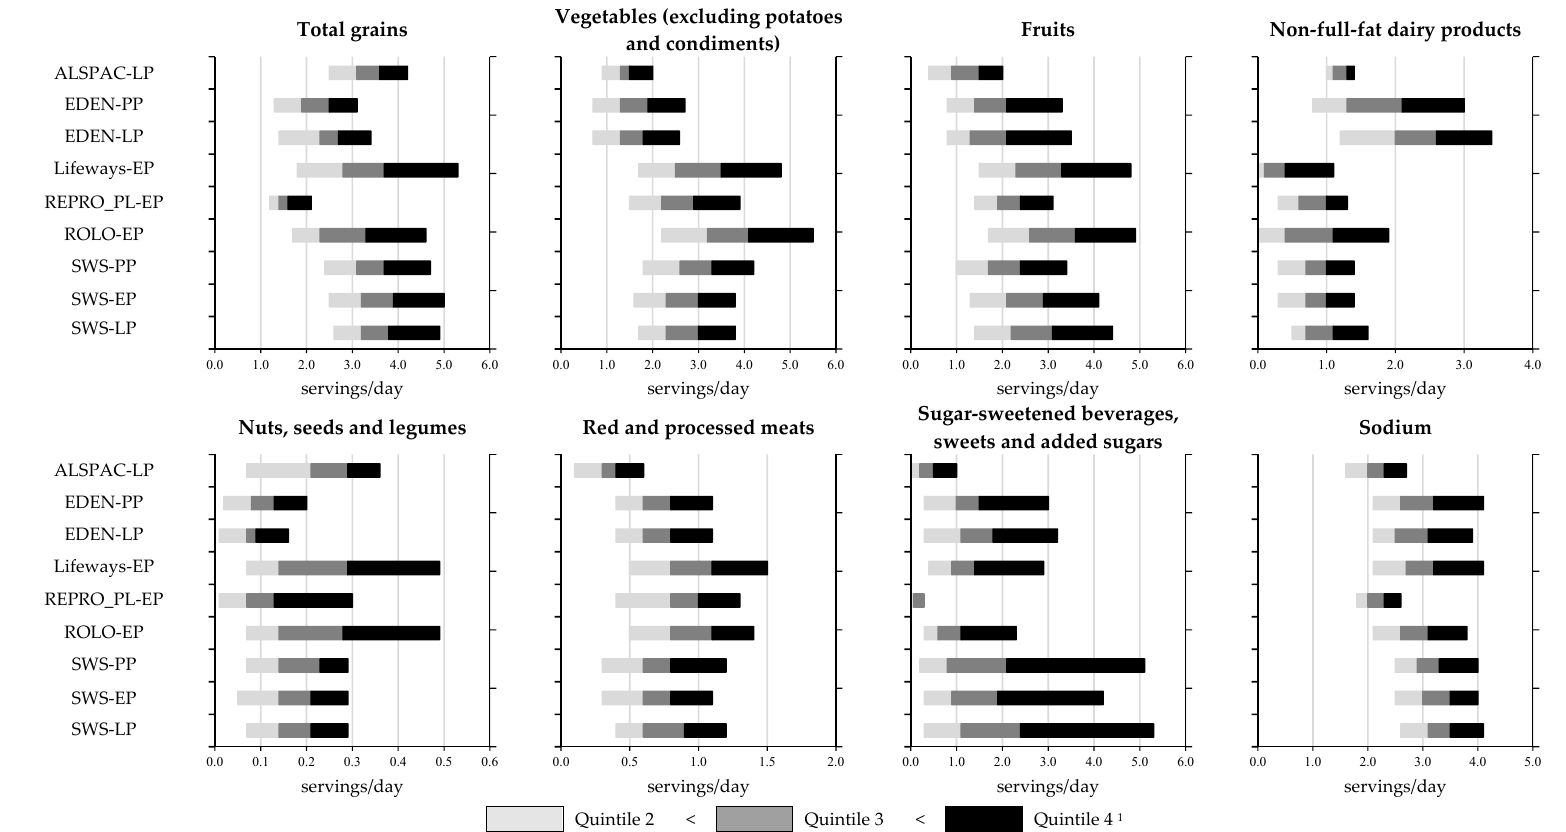
Figure 2. Maternal daily frequency consumption (in quintile) of the eight DASH food components by time point and cohort 1 in ALPHABET. PP: pre-pregnancy, EP: early pregnancy, LP: late pregnancy. Generation R data are only available in amount and thus not presented. 1 The quintiles 1 and 5 spread from the minimum to the quintile 2 limit and from the quintile 4 limit to the maximum, respectively. Maximum observed is likely to exceed x-abscissa and is not necessary the maximum presented in abscissa axis.